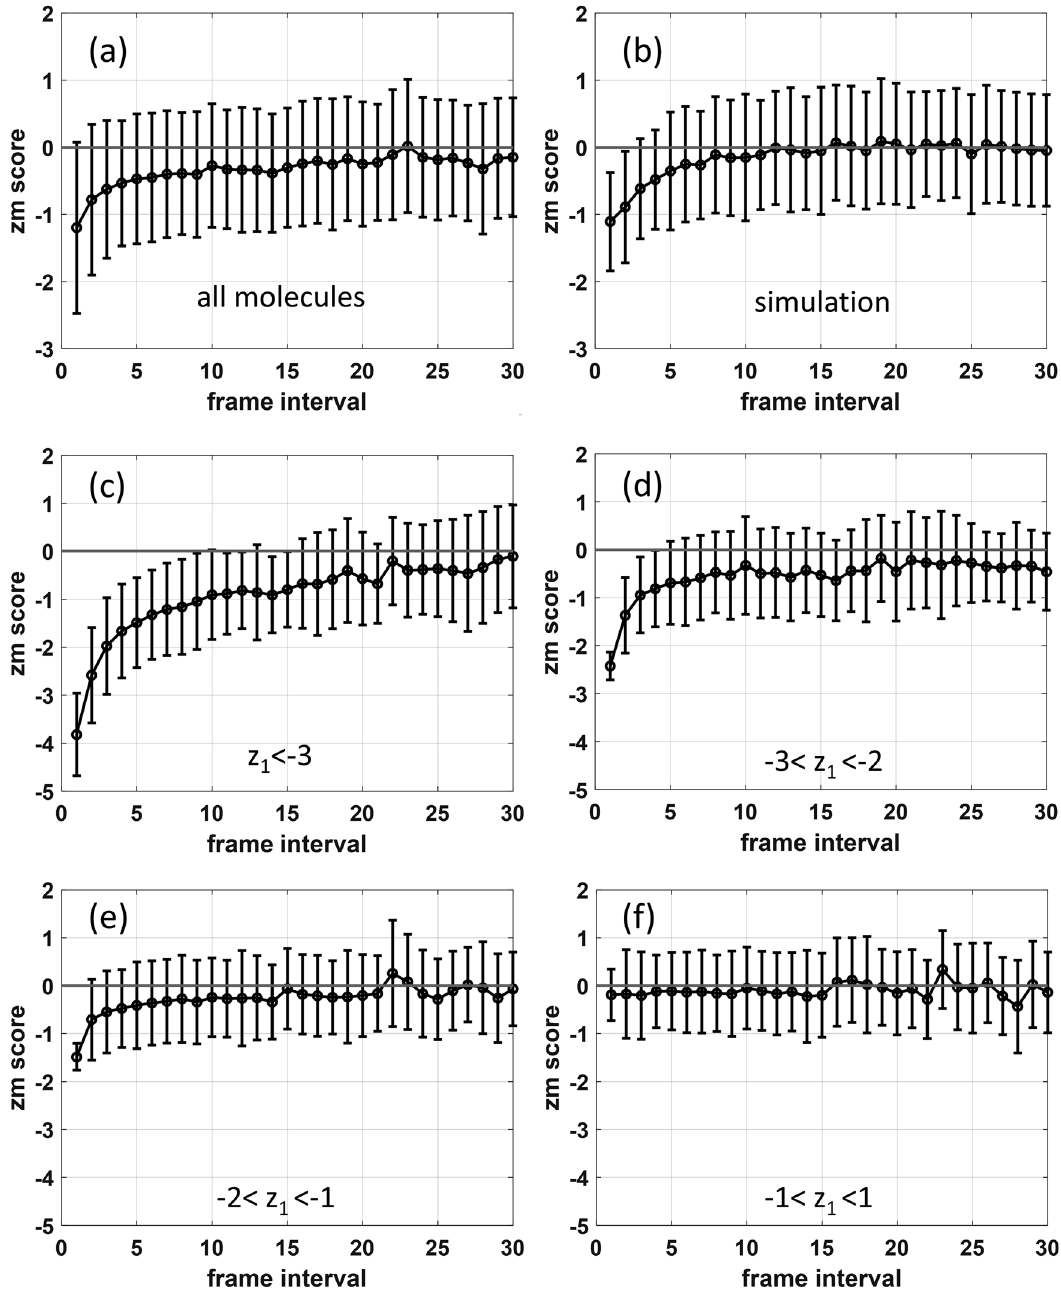
Figure 3: Experimental and theoretical calculations of the dynamic z m -score after drift correction show the stochastic motion of immobilized bio-molecules within con fi ned regions. (a)The z m -scoreswereplottedbasedonSTORMimagingdataof2073singlemoleculeswhenframeinterval m increasingfrom1to30.Errorbar representsthestandarddeviationof z m -scoresof2073moleculesforacertainintervalnumberm.(b)Thesimulated z m -scoresaveragedby200 moleculesshowsimilarsaturationpatternwhenframeinterval m increasingfrom1to30.(c) – (f)Thetotal2073moleculesaredividedintofour groups according to different scales of z 1 -scores, and their corresponding z m -scores are separately plotted. For the molecules with a z 1 < − 1 (c) – (e),the z m -scoresincreaseandsaturateataround0after m reachesa certainnumber.Forthemoleculeswith a z 1 -scoresbetween − 1and1 (f), the z m -scores randomly fl uctuate around